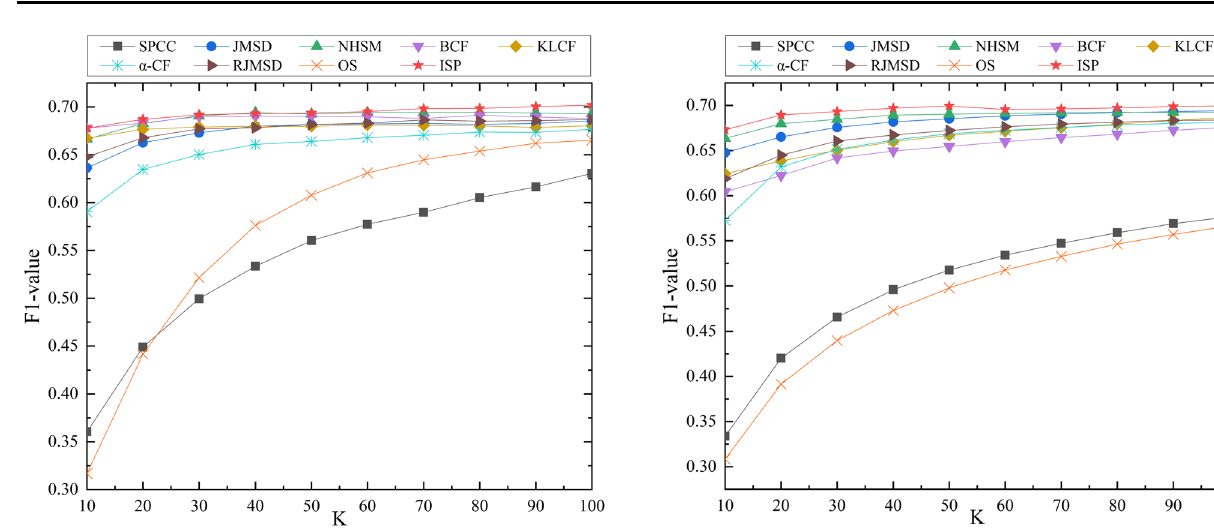
Fig. 5 F1-value of all algorithms in ML-100K Fig. 6 F1-value of all algorithms in ML-1 M